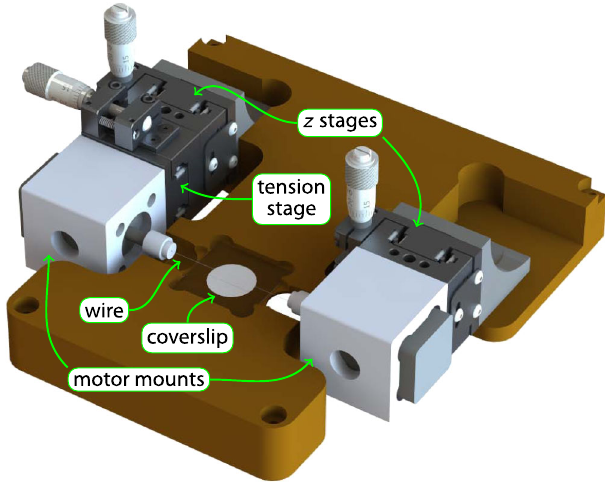
FIG. 3. The apparatus used to collect data on the rotation- induced macromolecular spooling of DNA. The microwire is situated directly above the cover slip using the z stages of the two motor mounts, and the tension stage is adjusted so that the microwire is taut. Solution containing DNA is dropped onto the cover slip such that a portion of the wire is submerged. The motors are driven simultaneously by an Arduino